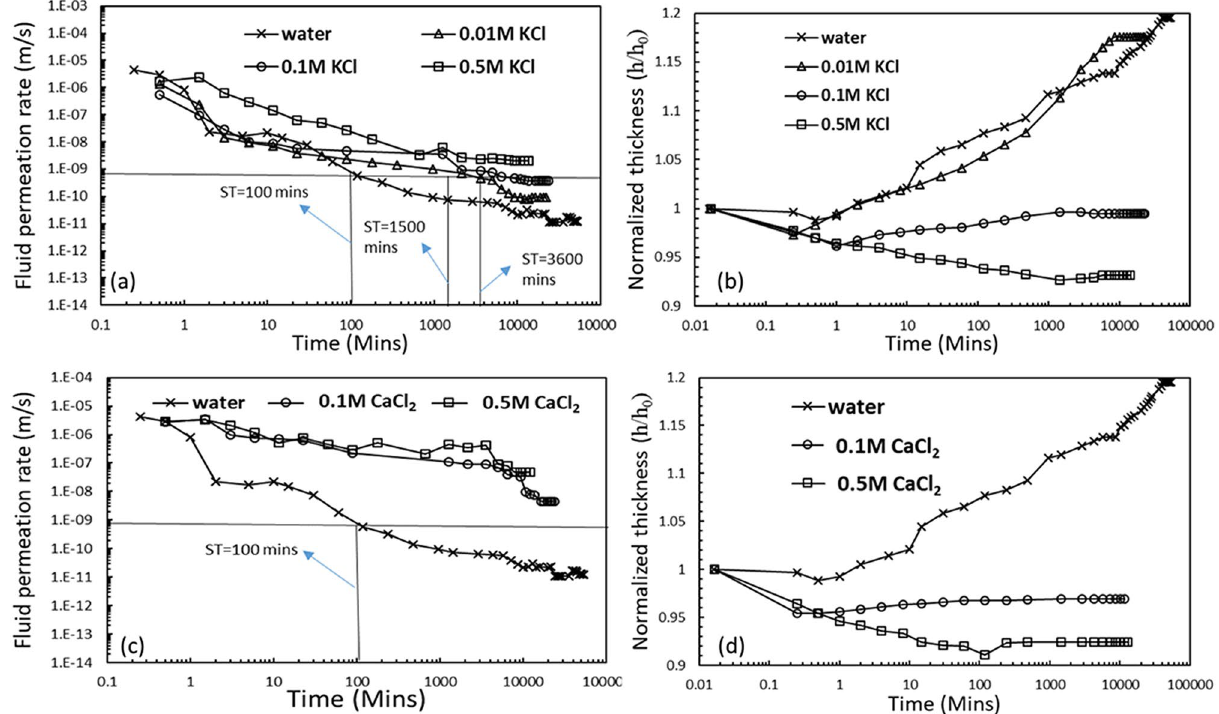
Figure 2. Temporal variation of ( a ) fluid permeation rate, and ( b ) normalized thickness for the GB under applied stress of 50 kPa in the presence of water and various concentrations of KCl; temporal variation of the ( a ) fluid permeation rate, and ( b ) normalized thickness of GB under applied stress of 50 kPa in the presence of water and various concentrations of CaCl 2